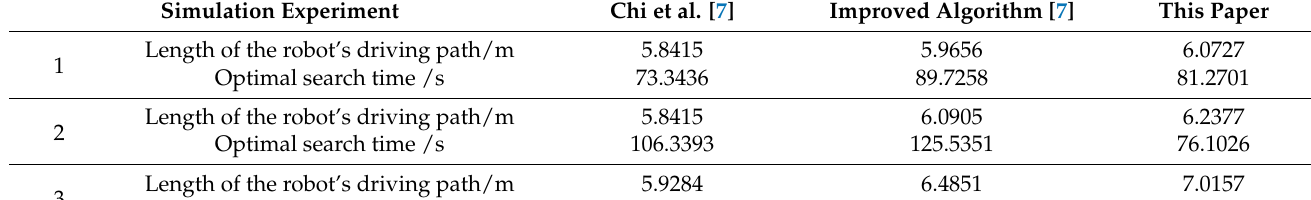
Table 8. Performance analysis of IACO-IDWA for path planning.